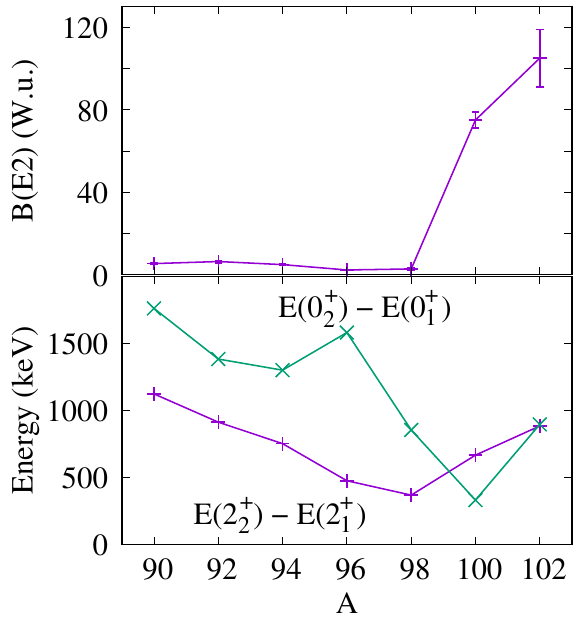
states and between the 1 , 2